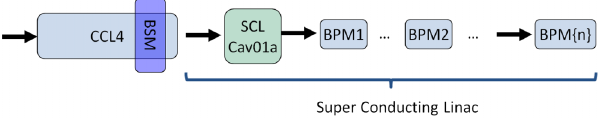
FIG. 1. The experimental setup